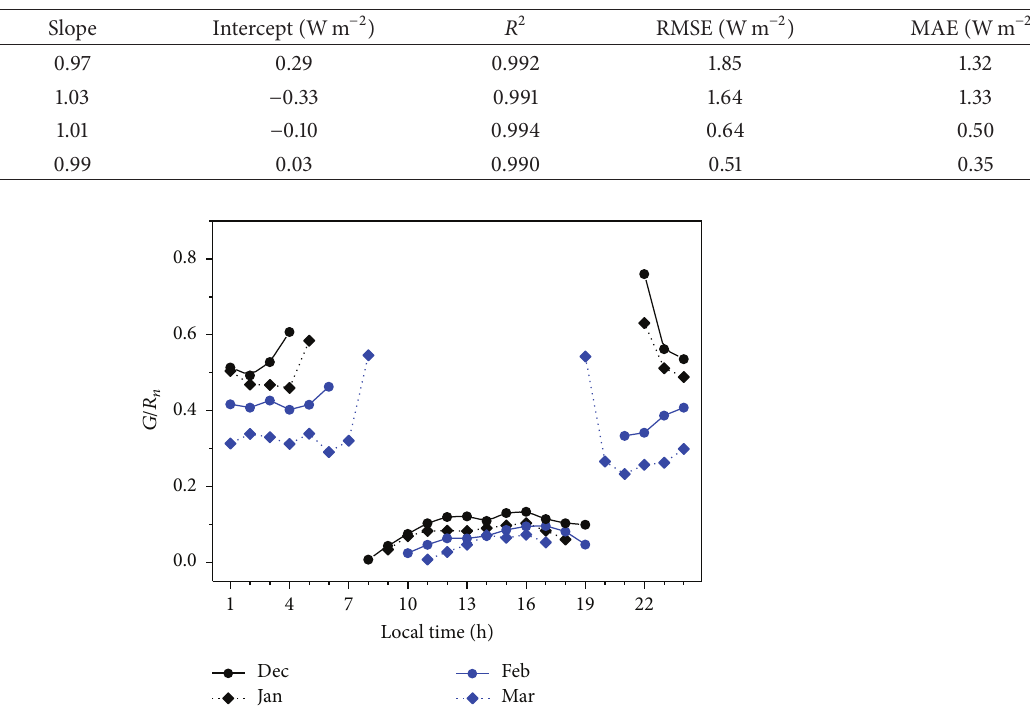
Table 3: Statistical evaluation of observed and modelled soil heat flux for the investigated months.